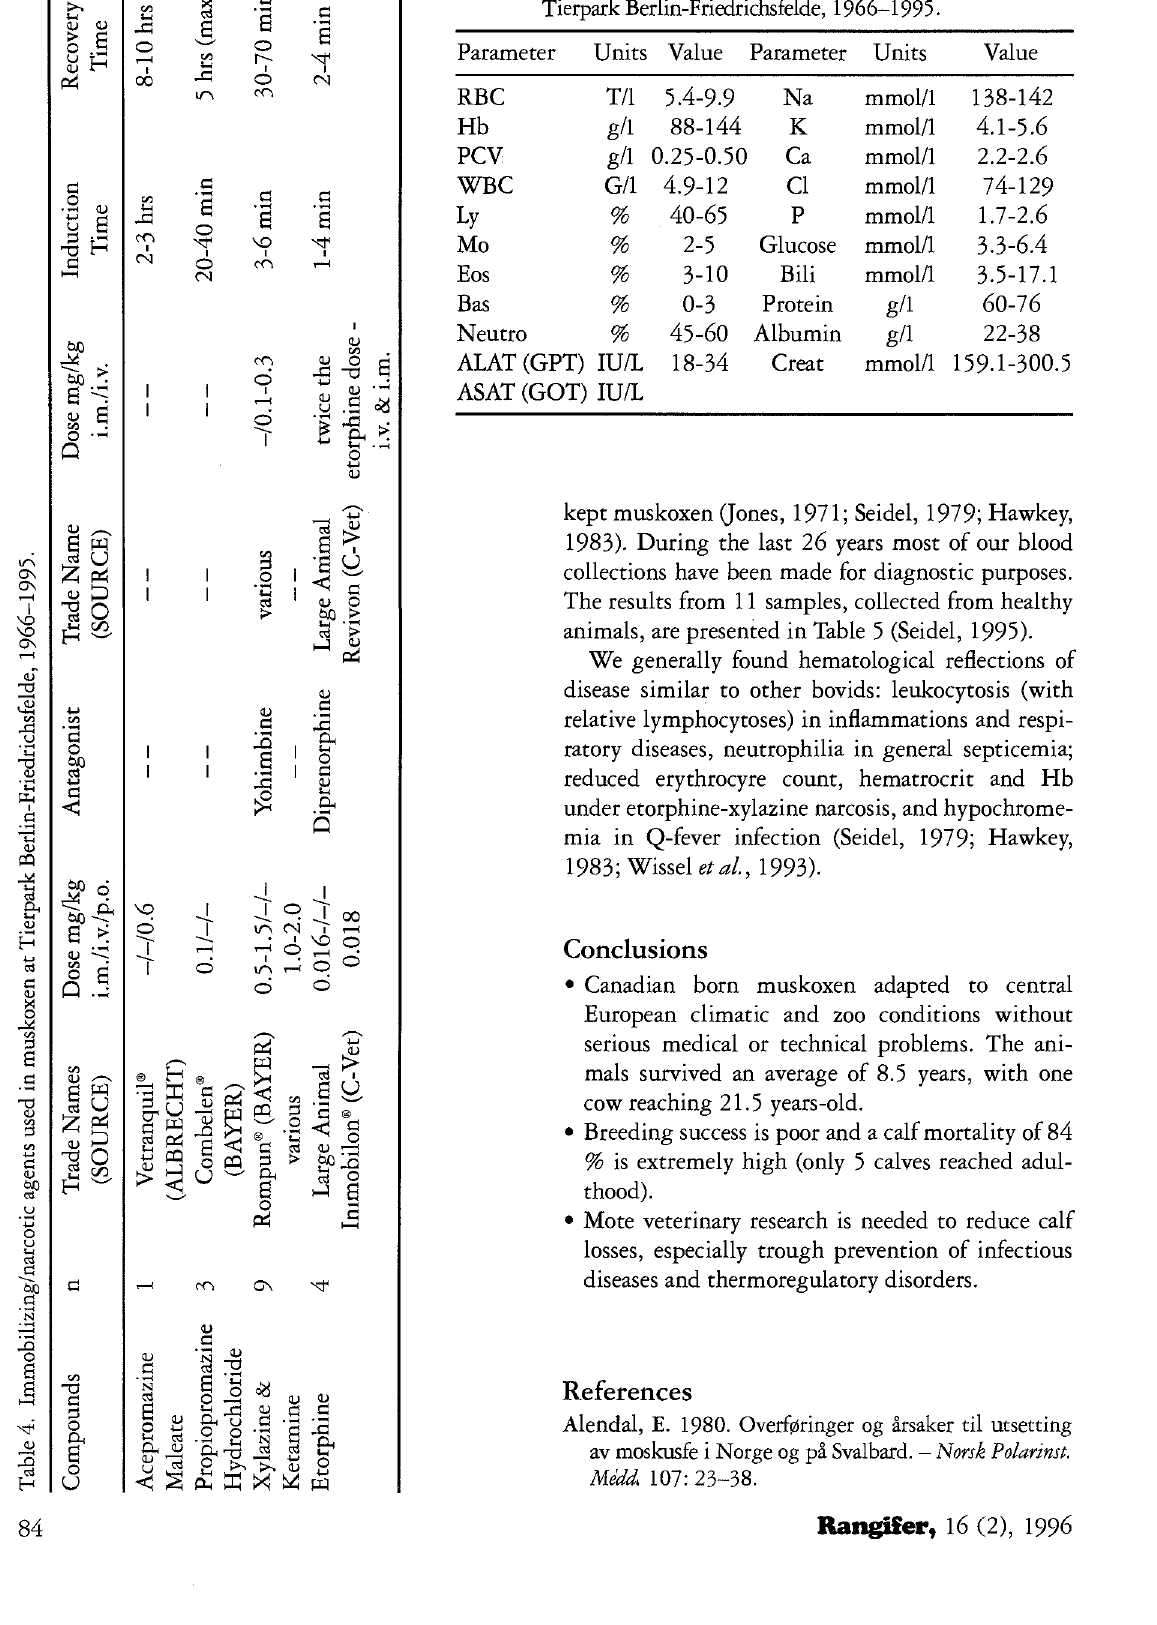
Table 5. Blood chemistry values from 11 healthy muskoxen raised at Tierpark Berlin-Friedrichsfelde,